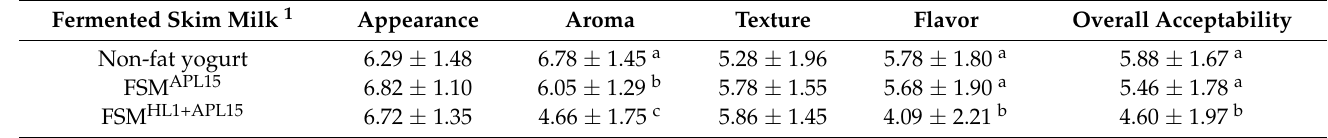
Table 2. Effect of starter cultures on sensory profiles of the fermented skimmed milk samples. Fermented Skim Milk